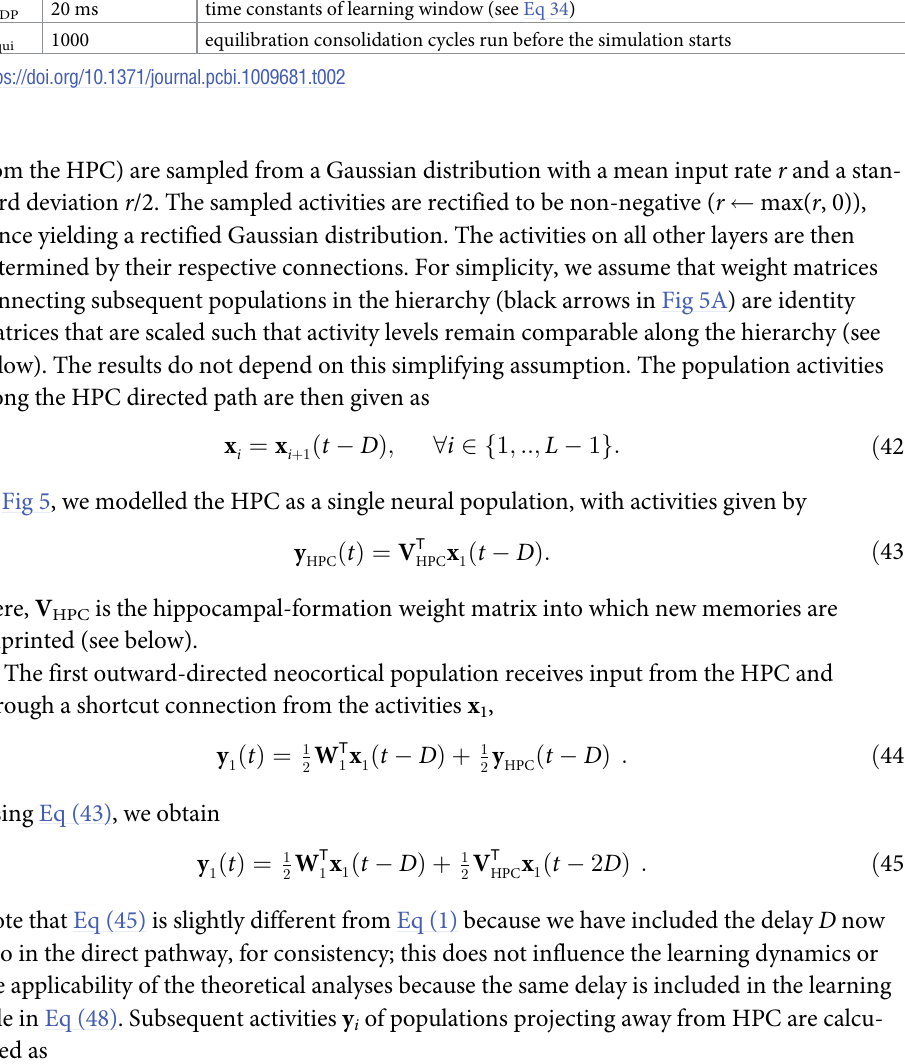
height of potentiating learning window for connections between populations at level i